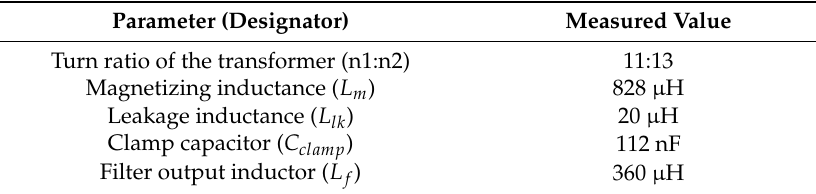
Figure 9. Picture of the proposed converter. Table 4. Parameter design results. Table 3. Design specification of the proposed converter.